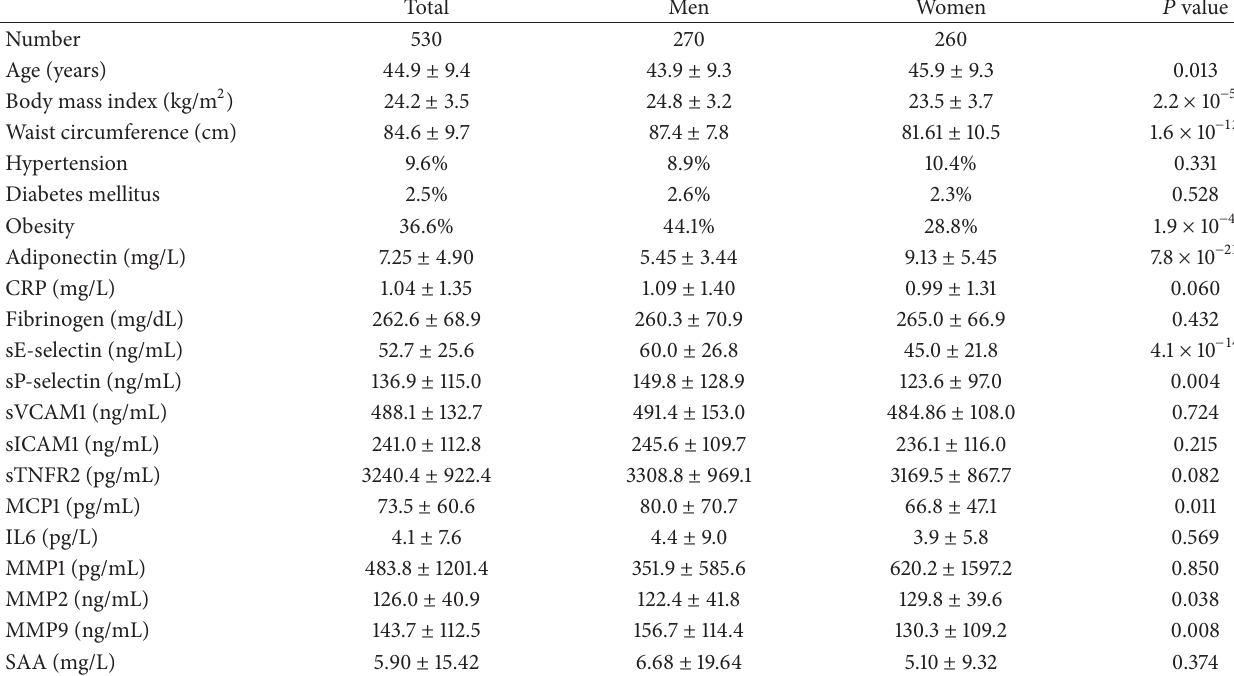
Table 1: Baseline characteristics of the health of study participants.